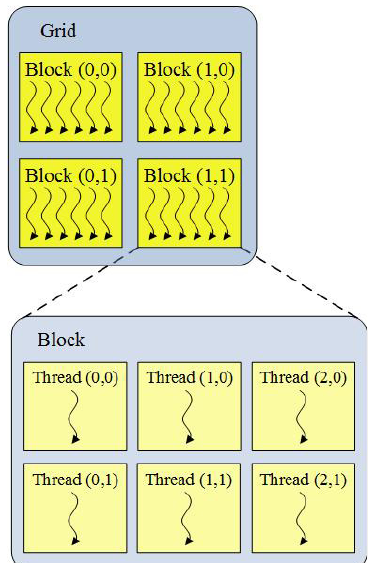
Figure 1. Illustration of a grid of blocks of